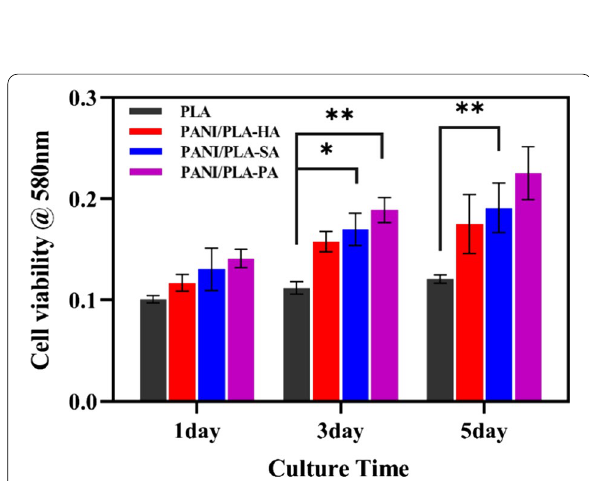
Fig.9 Cell viability HOS cultured for 1, 3, and 5 days on PLA nanofibers and PANI/PLA composite nanofibers (* p < 0.05; ** p <